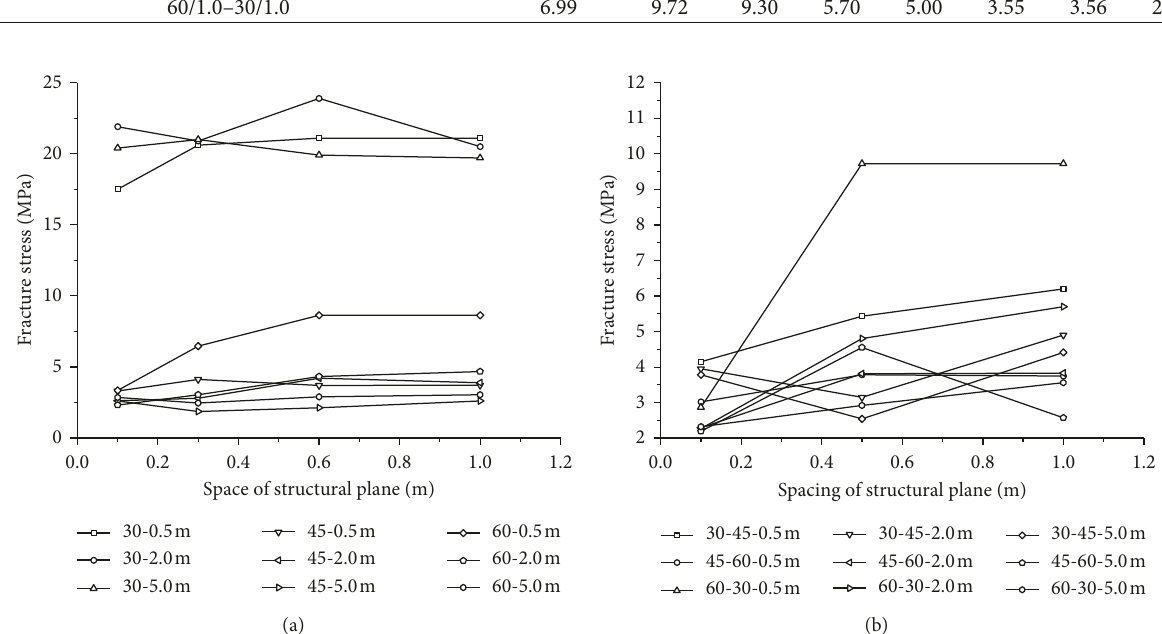
Figure 9: Fracture stresses of rockmass with different spacing of structure plane when the confining pressure is 1.5 MPa: (a) rockmass with a single structure plane and (b) rockmass with an X-shaped combined structure